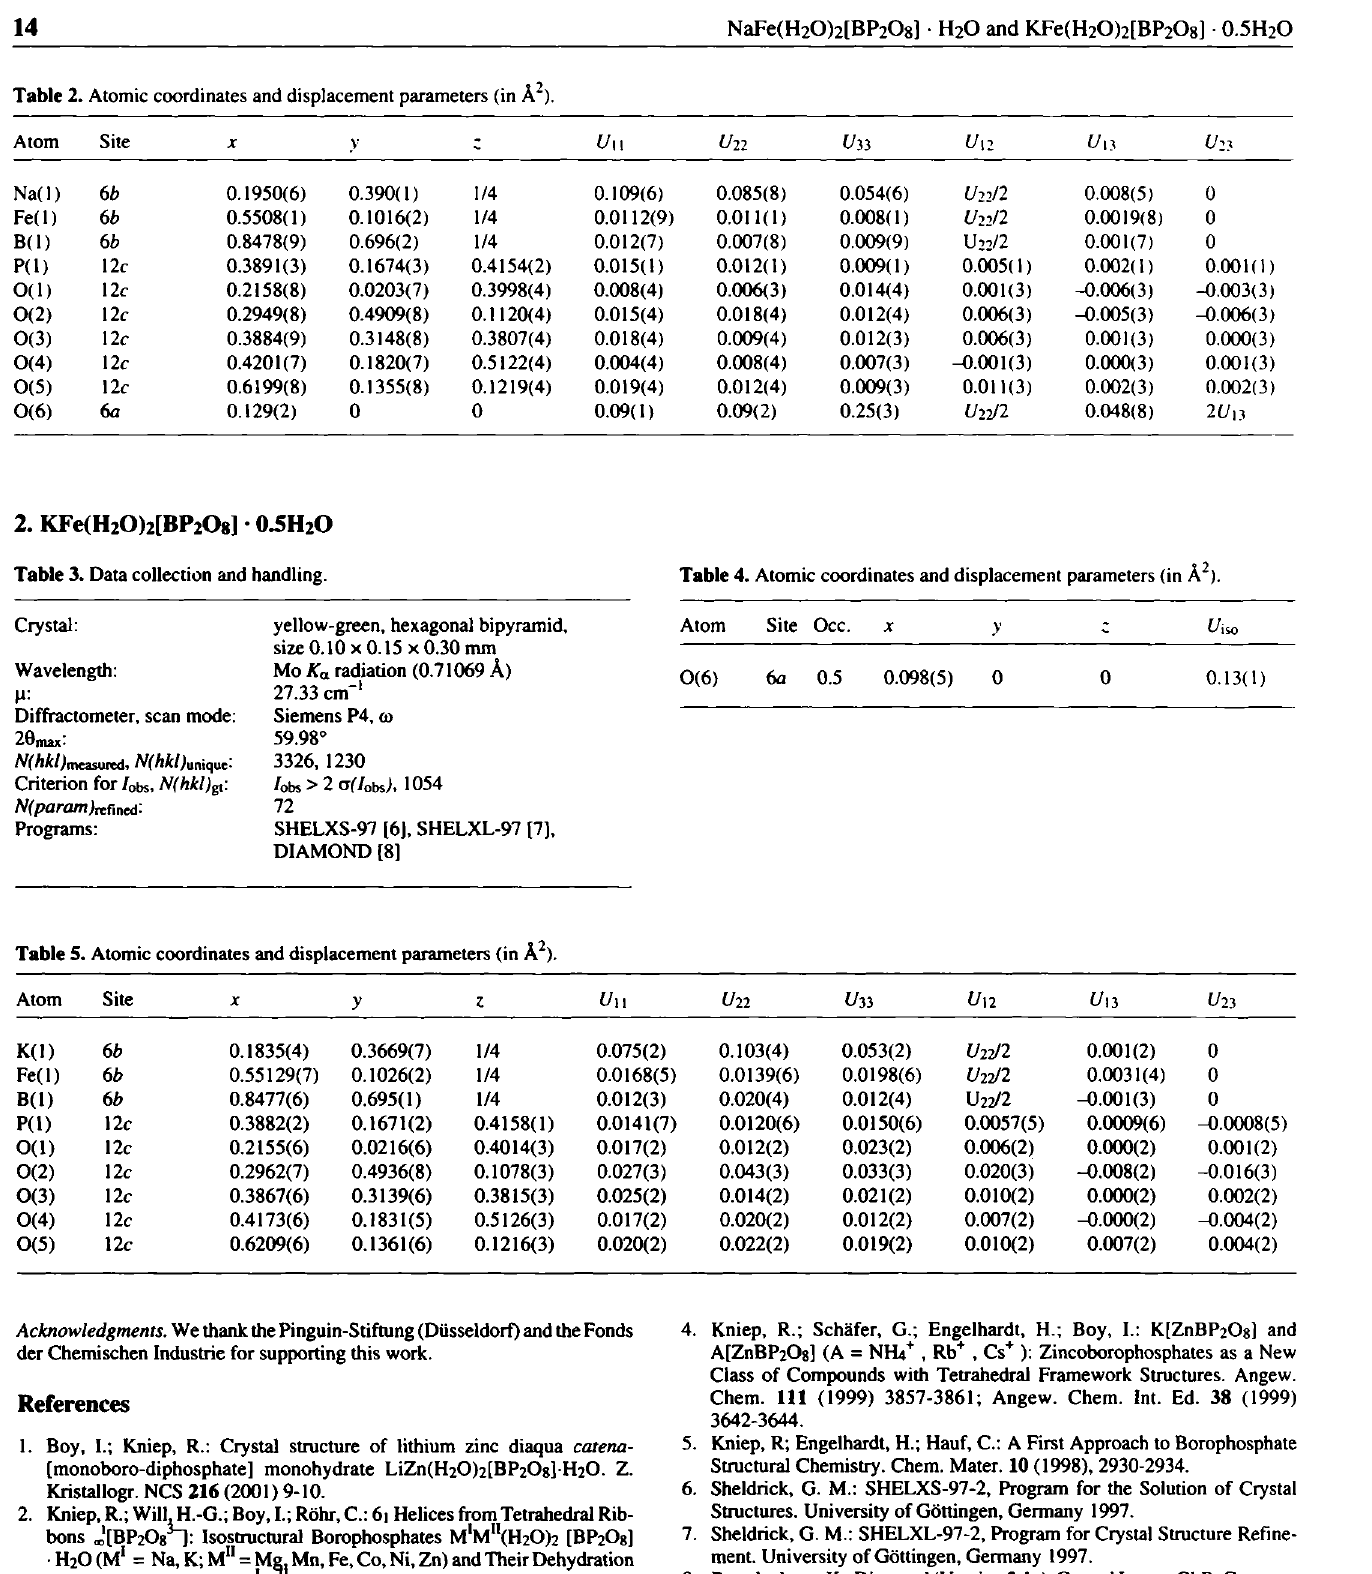
Table 5. Atomic coordinates and displacement parameters (in A 2